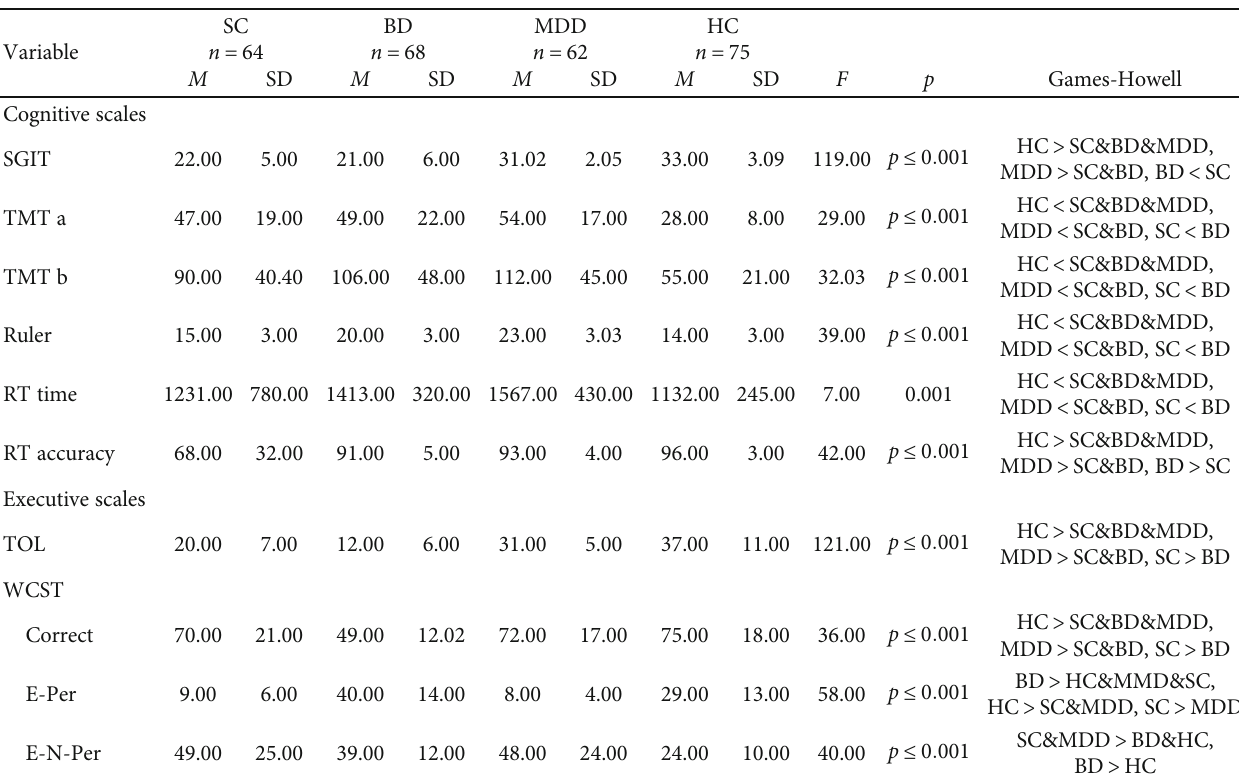
Table 2: Results of the multivariate analysis of variance (MANOVA) in cognitive and executive function